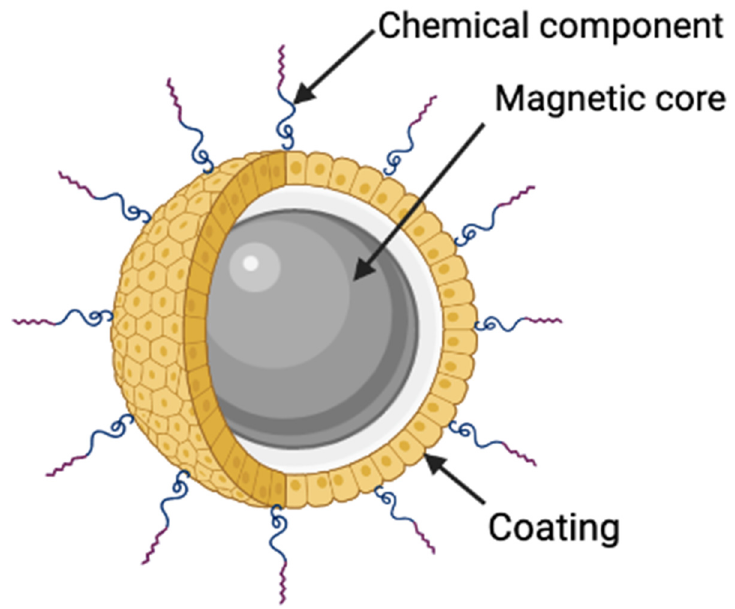
Figure 1. Components of a typical MNP.